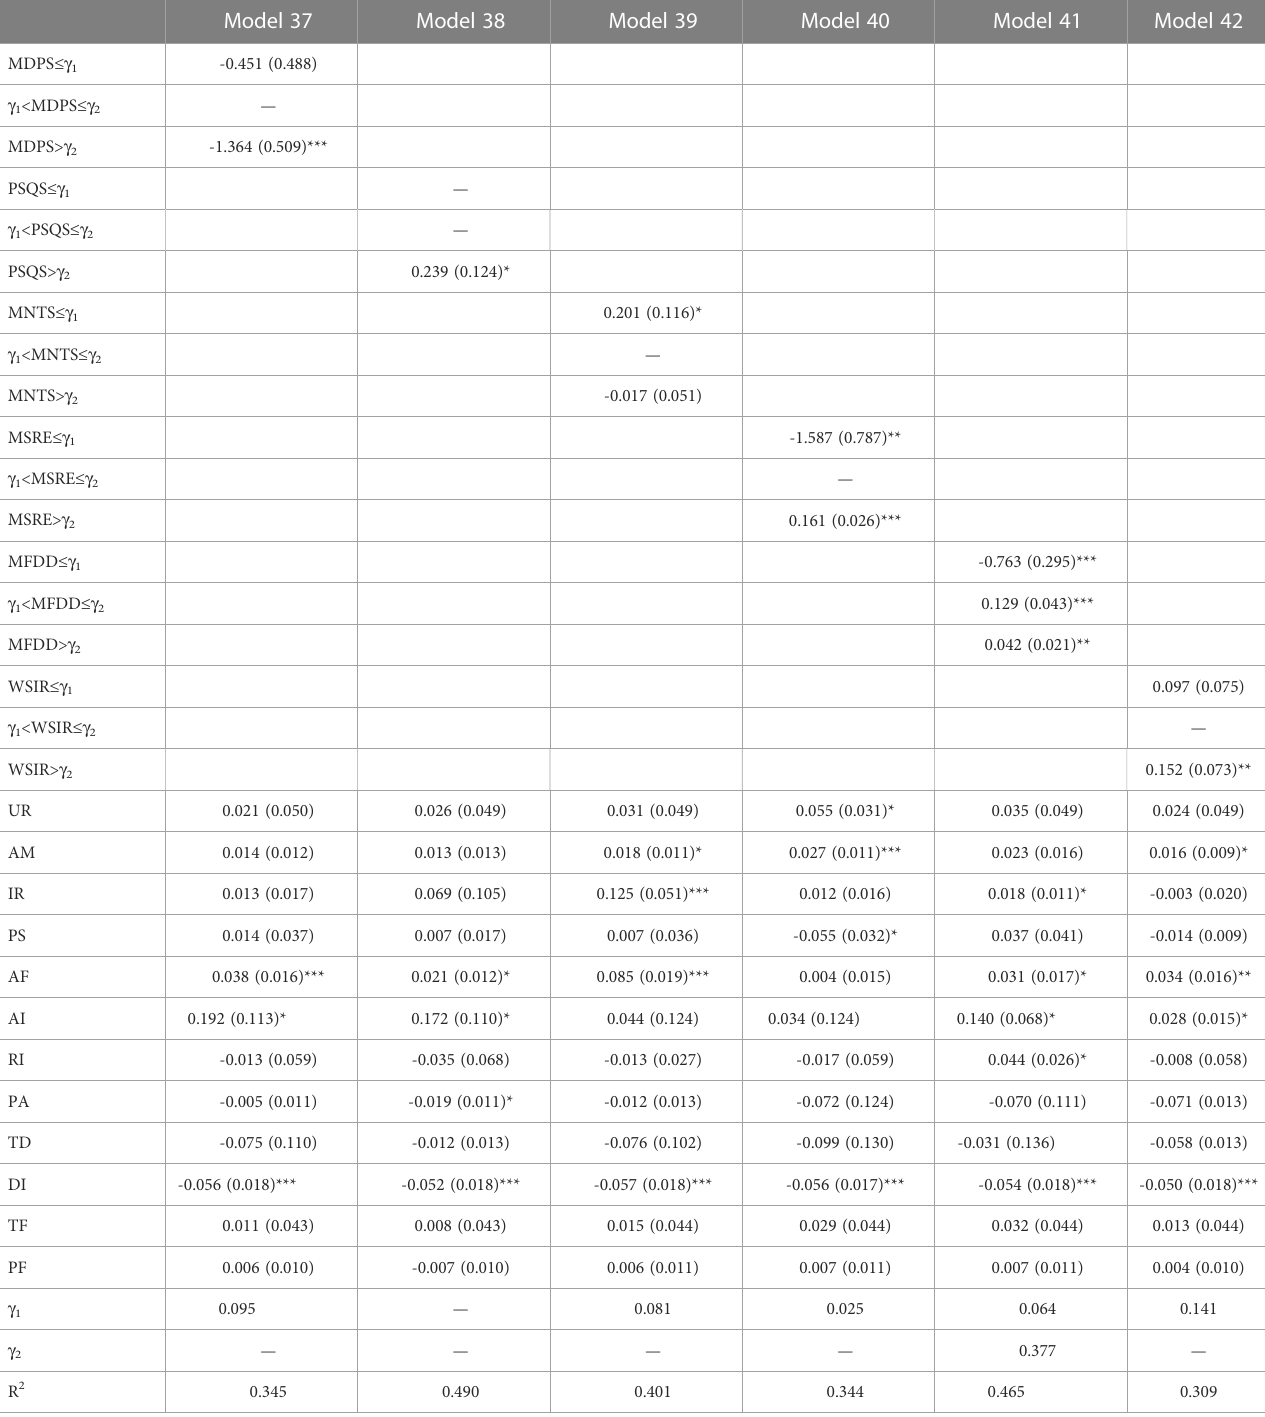
TABLE 7 The threshold model results of GTCG in the whole